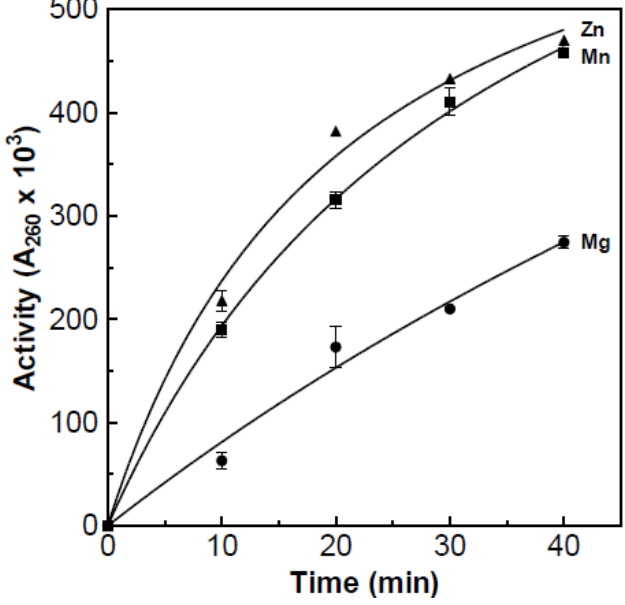
Figure 9. The effect of various metal ions on partially purified RNase activity. The results were obtained using the acid soluble assay at 55 °C with 50 mM/mL of the designated metal ions added to the substrate. Prior to the experiment 20 mM/mL of EDTA was added to the partially purified